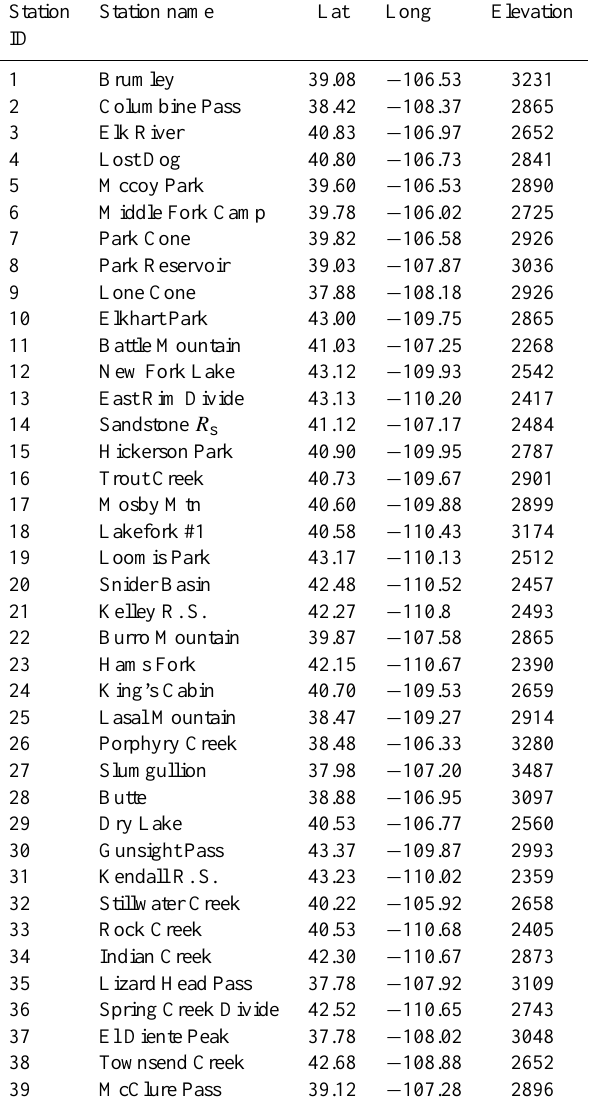
Table 2. Locations of the SNOTEL station where simulated SWE and MI-estimated SWE were validated.